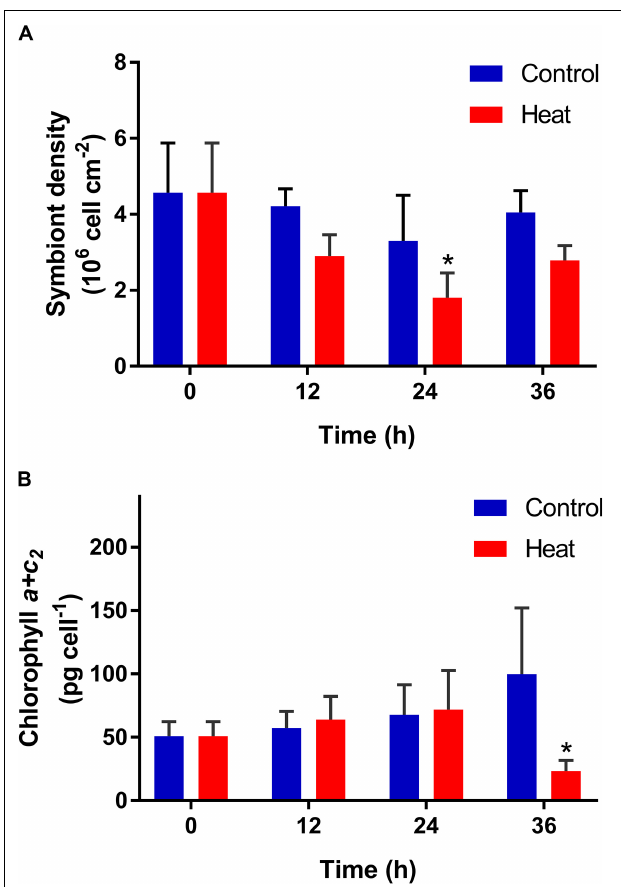
FIGURE 1 | Temporal variation of symbiont density (A) and chlorophyll content (B) in the scleractinian coral Pocillopora damicornis after heat treatment. Data points represent means, and error bars represent standard deviations ( N = 6). Asterisks depict significant differences between the heat and control groups ( p <